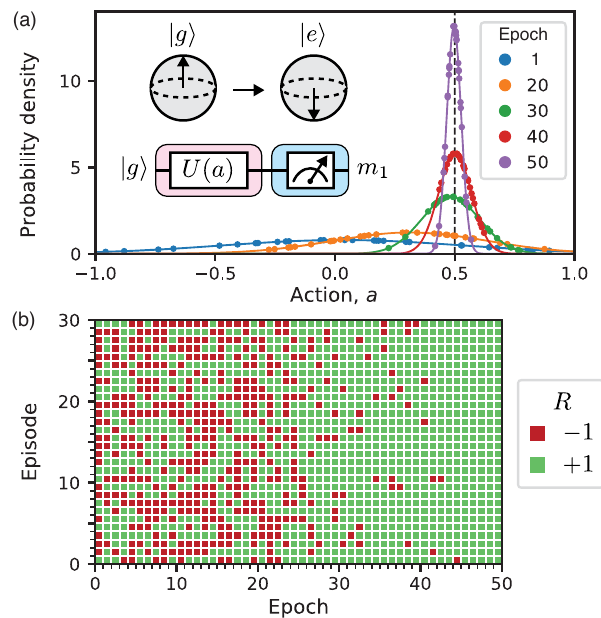
FIG. 6. Educational example of model-free learning. (a) Inset: The task is to prepare qubit state j e i starting from state j g i . Episodes consist of a single time step; the control circuit contains a rotation unitary U ð a Þ , and the reward circuit contains a measurement of σ . Main panel: policy distribution (solid lines) z for a selected set of epochs, and actions that the agent tried in the episodes of corresponding epoch (dots). (b) Rewards received by the agent in the episodes of every